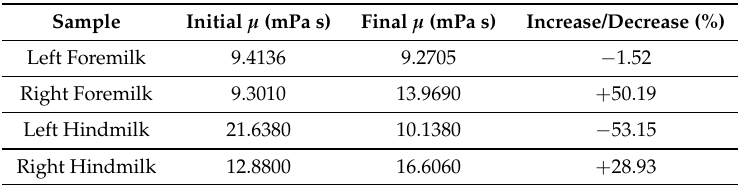
Table 7. Start and end viscosities at 1 s − 1 for the loop